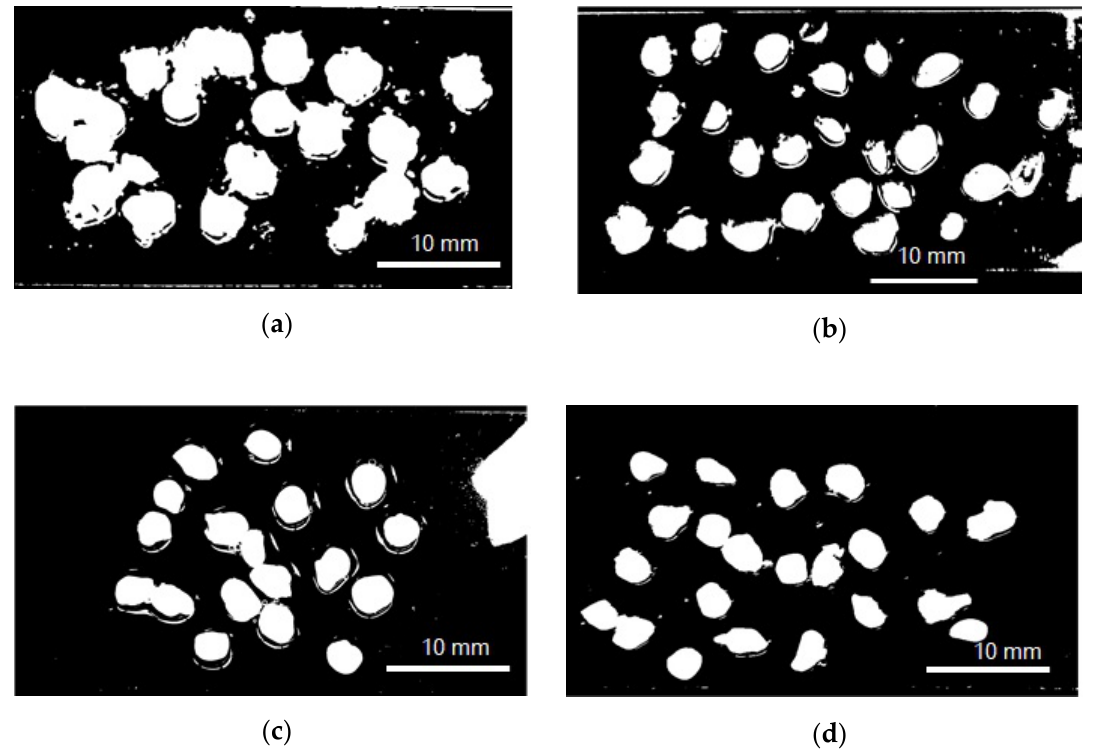
Table 1. Comparison of the encapsulation efficiency and particle size of encapsulated annatto extracts.